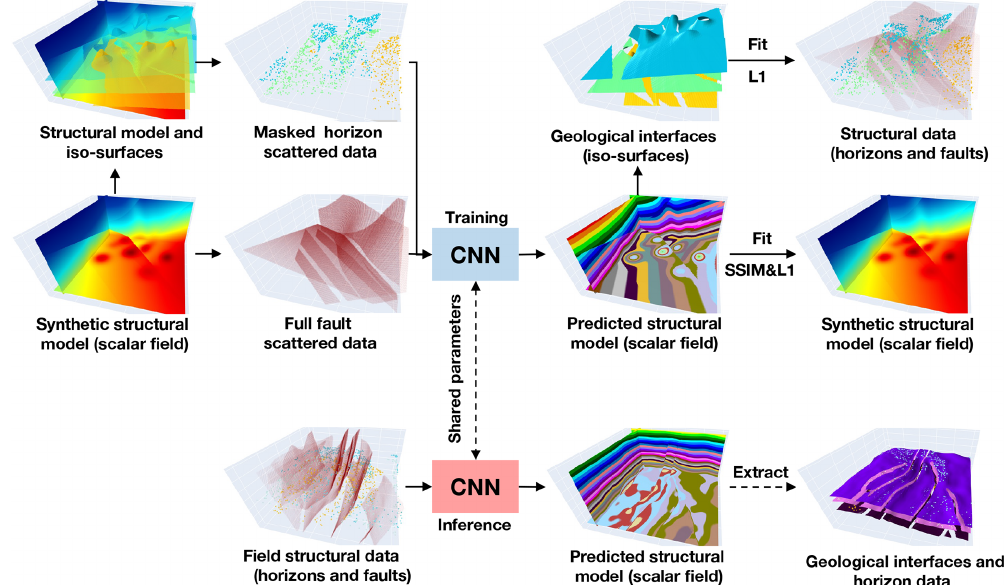
Figure 1. Our implicit modeling method produces a volumetric scalar function as an implicit representation of all the geological structures from input structural data by using a convolutional neural network (CNN). Trained with numerous synthetic data, the network can be applied to field structural data to efficiently predict a geologically reasonable model that matches the inputs well.